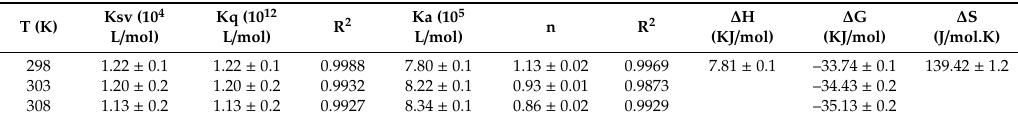
Relevant parameters of the Stern–Volmer quenching constant (Ksv), the biological macromolecules quenching constant (Kq), the binding constant (Ka), and the number of binding sites (n) were calculated from Stern–Volmer and double log plots at di ff erent temperatures. Thermodynamic parameters of enthalpy ( ∆ H), entropy ( ∆ S) and free energy ( ∆ G) changed based on the van’t Ho ff